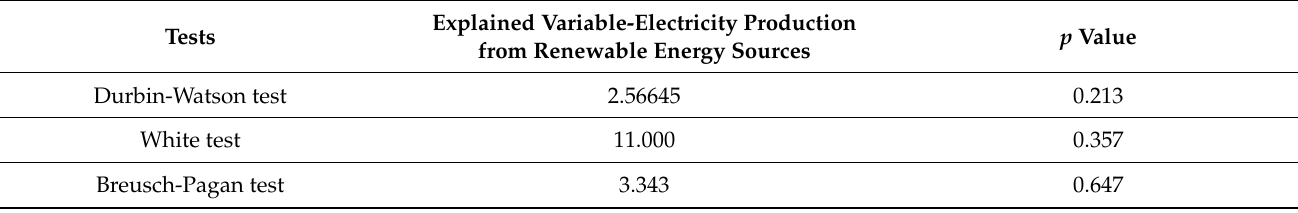
Table 4. Results of the tests for the